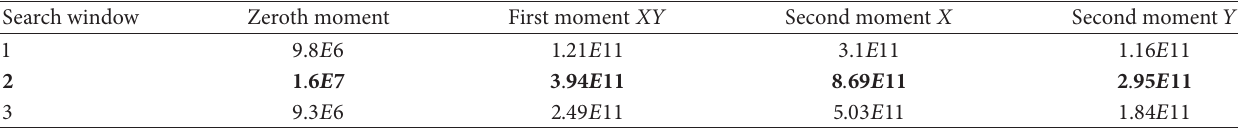
Table 2: Moments measurement from different search windows for SUED.